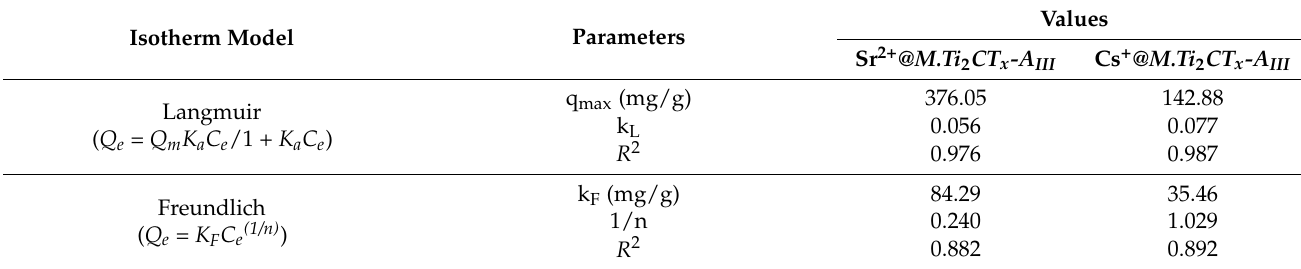
Table 4. Langmuir and Freundlich adsorption isotherm parameters for Sr 2+ and Cs + adsorption on M.Ti 2 CT x -A III